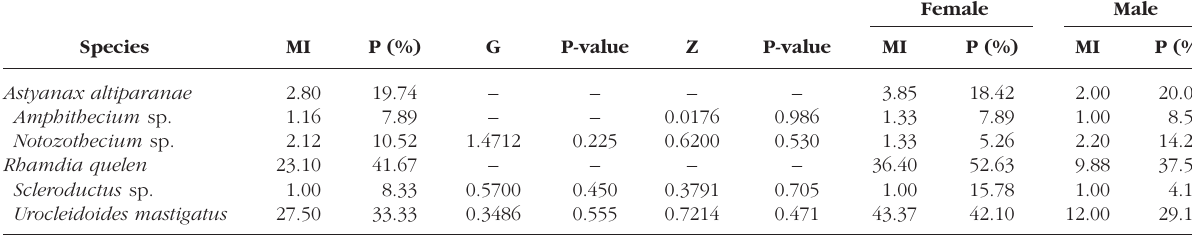
Table I. – Mean intensity (MI) and prevalence (P) of infestation, Log-likelihood (G) and Mann-Whitney (Z) test statistics and significance level of monogenean parasites in Astyanax altiparanae and Rhamdia quelen , and MI and P for male and female hosts separately.